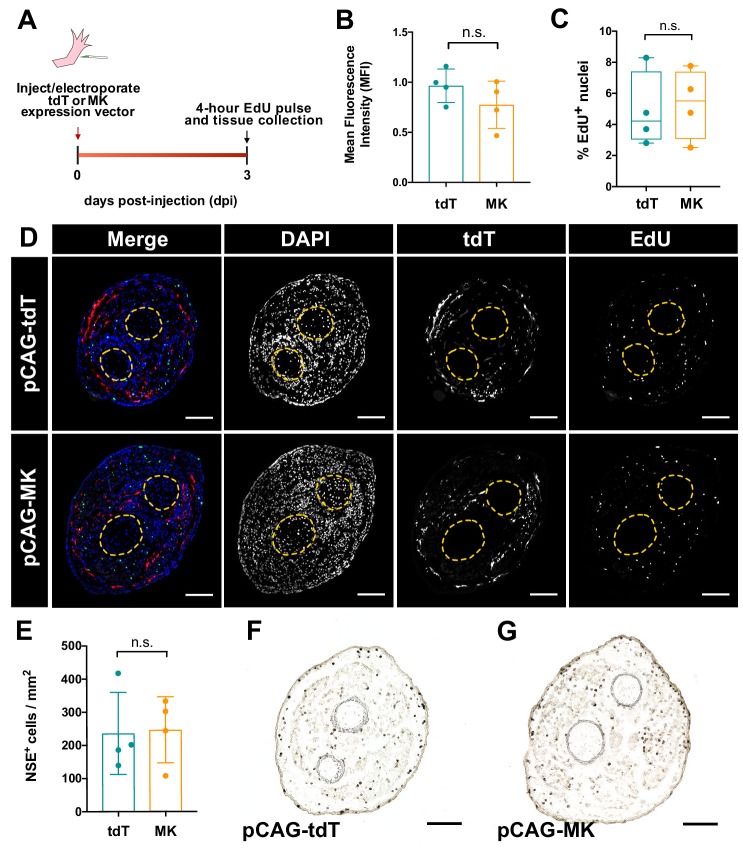
Overexpression of mk in non-regenerating intact limbs does not affect cellular proliferation or monocyte density.(A) Experimental schematic of overexpression experiment in non-regenerating limbs. (B) Mean fluorescence intensity (MFI) quantification of electroporated limbs. (C) Quantification of the percentage of EdU+ cells in tdT- or mk-overexpressing intact limbs. (D) Representative images of tdT and EdU-stained cross-sections from electroporated limbs. (E) Quantification of monocyte density in overexpression limbs. (F–G) Representative images from NSE+ stained sections from non-regenerating overexpression limbs. Two-tailed unpaired t-tests were performed for statistical analysis. Graphs are mean ± SD. Scale bars, D, F-G: 200 um. n.s., not significant.